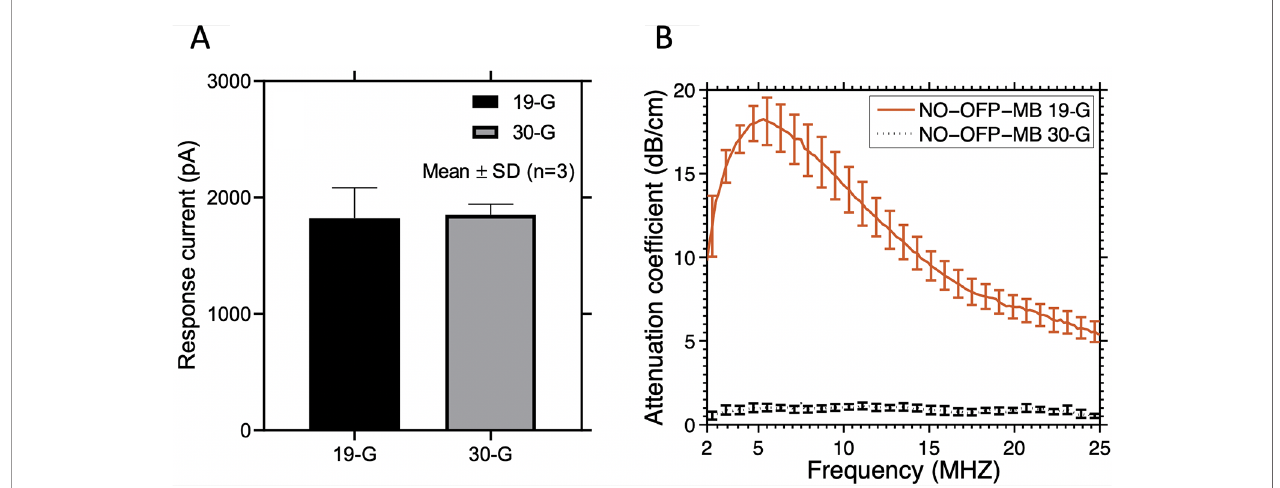
FIGURE 3 | (A) The response current of the amperometric microelectrode sensor to NO-saturated solution obtained after injection through a 19-G or 30-G needle. (B) Attenuation coef fi cient of NO-OFP-MB 9:1 v/v obtained after injection through a 19-G or a 30-G needle. Injection through a 30-G needle resulted in a sharp decrease in the attenuation coef fi cient, and release of the gas payload. The mean ± 1 standard deviation is depicted (n = 3 per group) in each